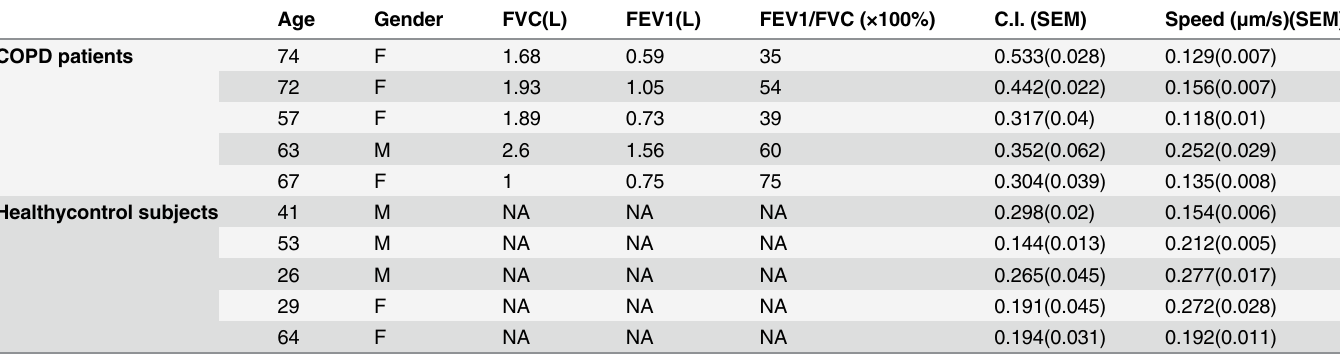
Table 1. The clinical descriptors and the chemotaxis measurements of the COPD patients and healthy control subjects in this